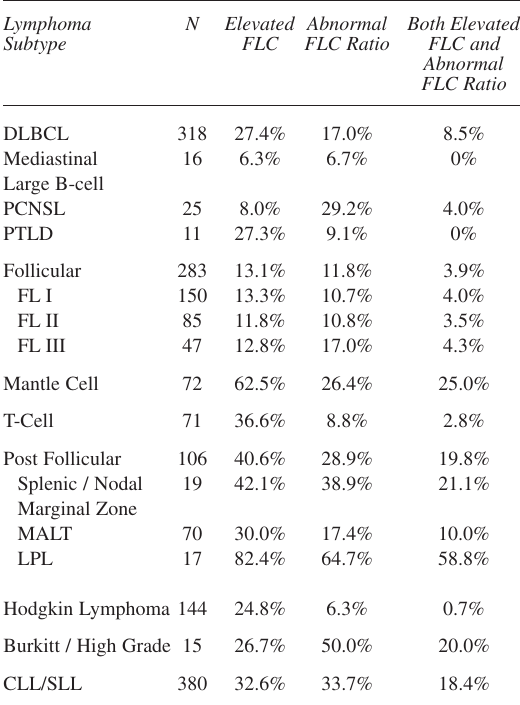
Table 1. Prevalence of FLC Abnormalities in Lymphoma in Mayo Clinic/University of Iowa SPORE Molecular Epidemiology Registry. Lymphoma